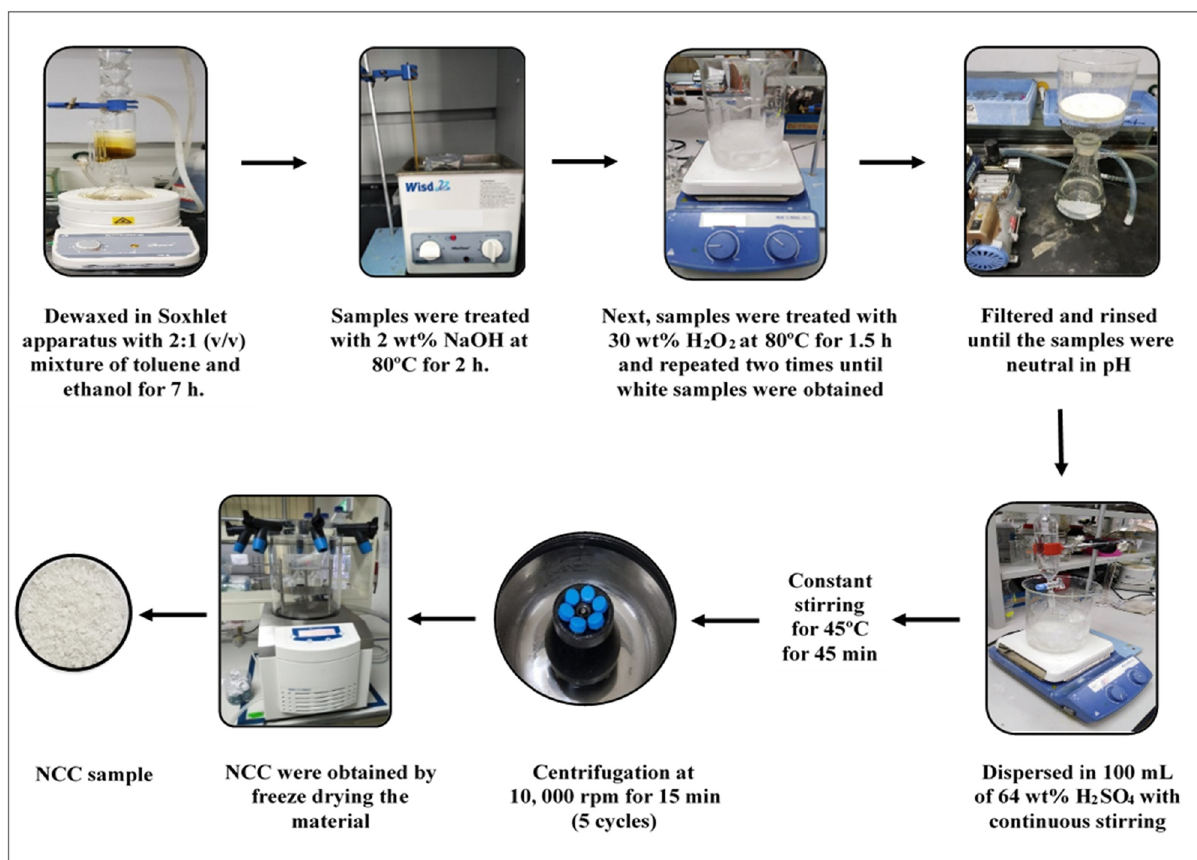
Figure 3: Procedures of preparation of NCC from pineapple